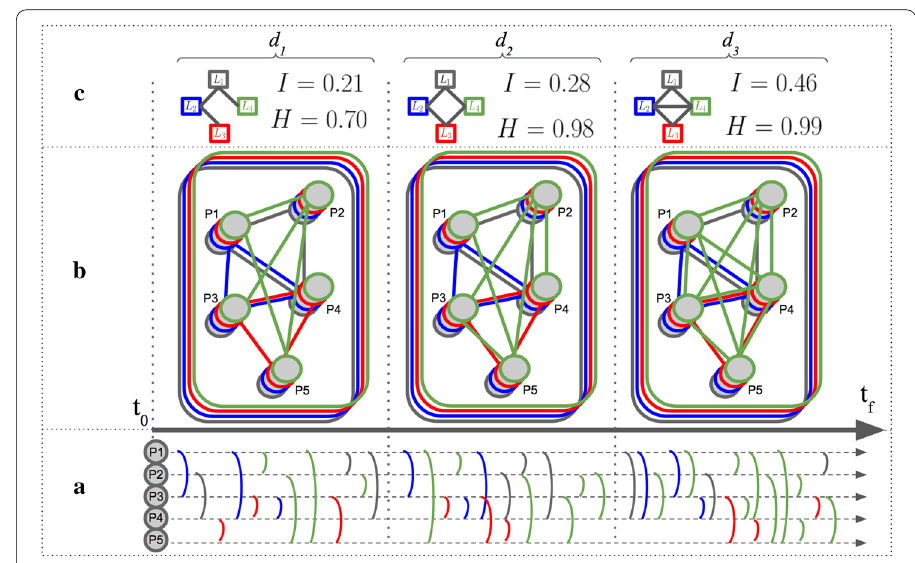
Fig. 5 Converting temporal edges of multiple types into temporal entanglement series. a Edges of different types are defined over time between t 0 and t f . b Time frames d 1 , d 2 , and d 3 are defined so we may construct the three corresponding multiplex network slices. c For each slice, we can compute a LIN and the corresponding entanglement intensity I and homogeneity H , which compose the series once taken together among all